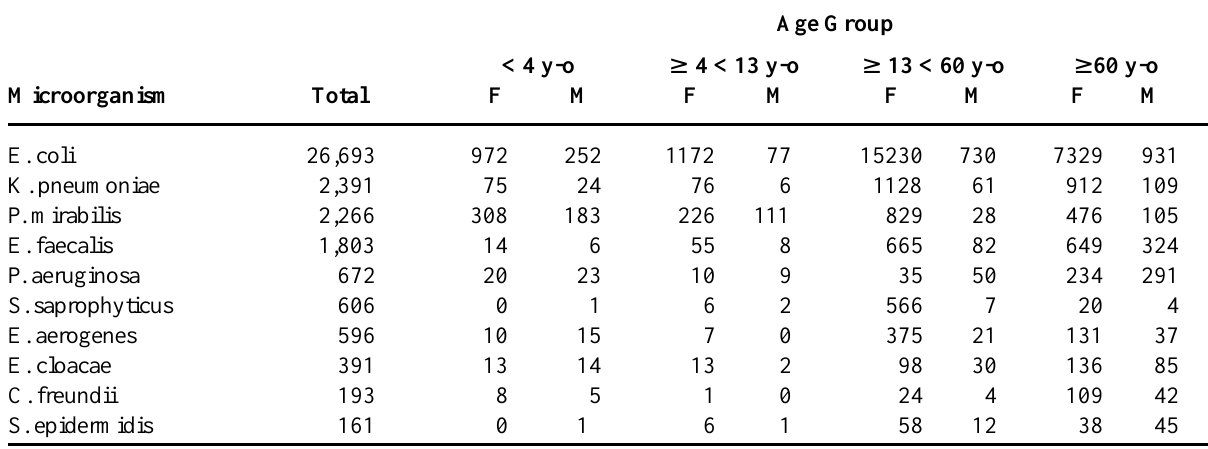
Table 1 – Total amount of microorganisms isolated from UTI in outpatients and their distribution according to age groups and gender, years 2000 to 2003, São Paulo,